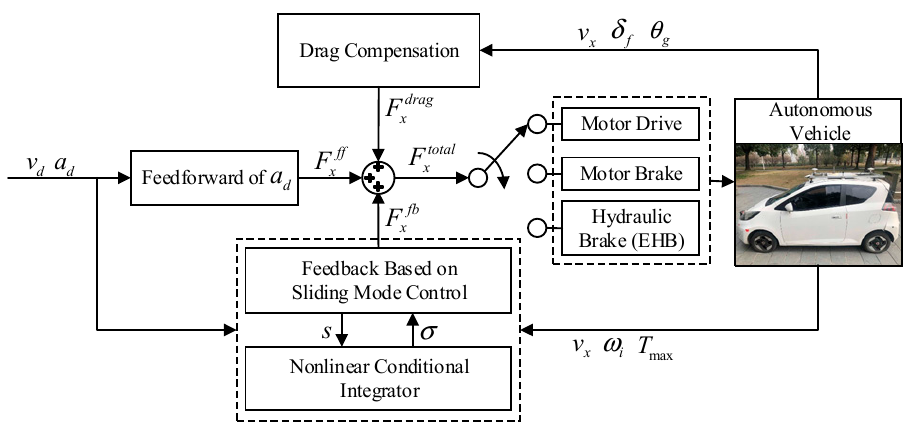
Figure 2. Block diagram of longitudinal speed controller via the sliding mode control with nonlinear conditional integrator.